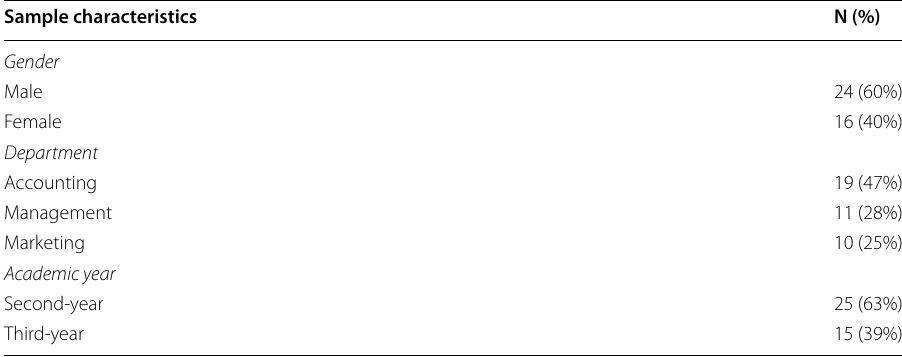
Table 1 Sample characteristics Sample